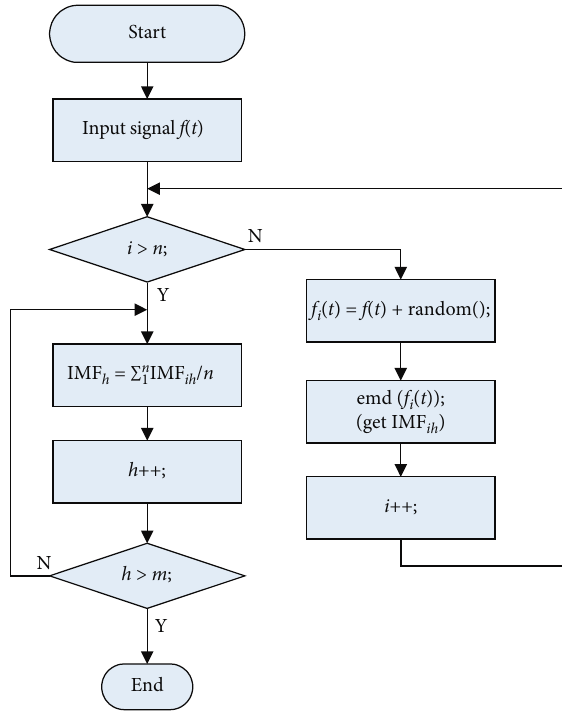
Figure 2: Flowchart of